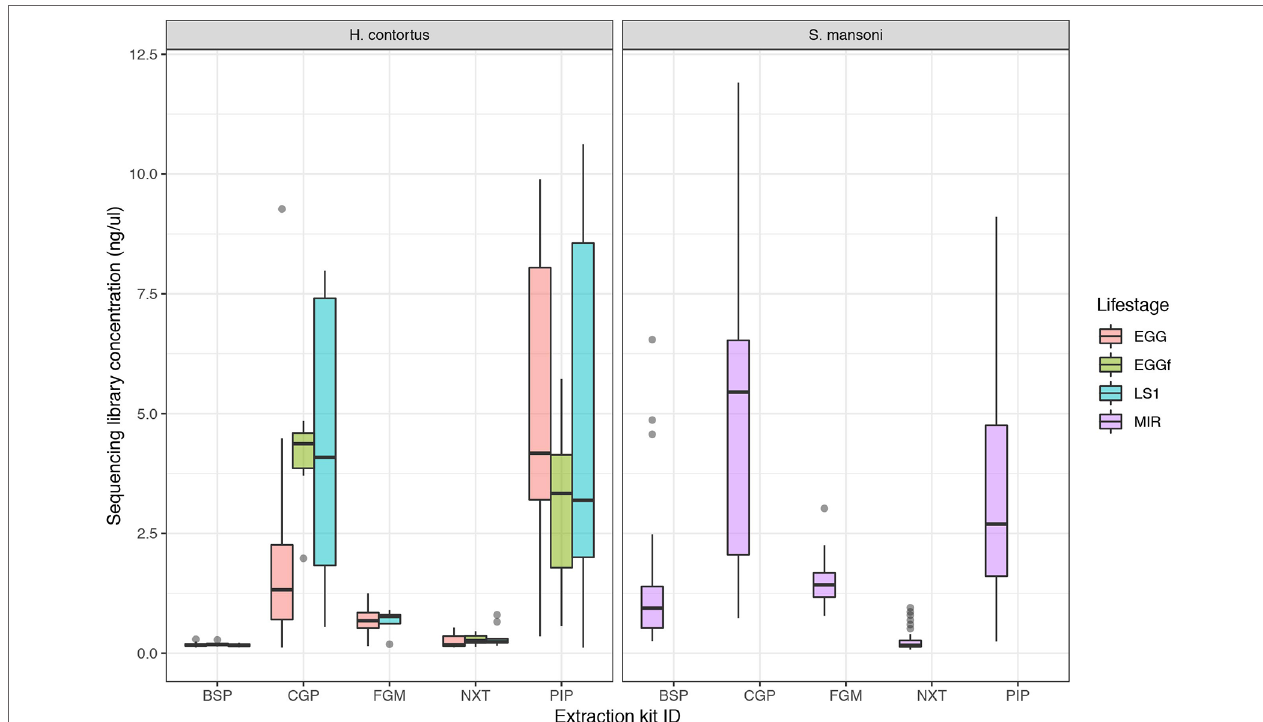
FIGURE 1 | Comparison of sequencing library concentration (ng/ µl ) as a proxy for relative DNA extraction efficiency for the five DNA extraction protocols tested. DNA from multiple life stages were extracted, including from freshly collected egg (EGG), frozen eggs (EGGf), and L1 stage larvae (LS1) of Haemonchus contortus , and miracidia (MIR) of Schistosoma mansoni . The number of samples in each comparison is presented in Table 1 , and the raw data used are described in Table S1